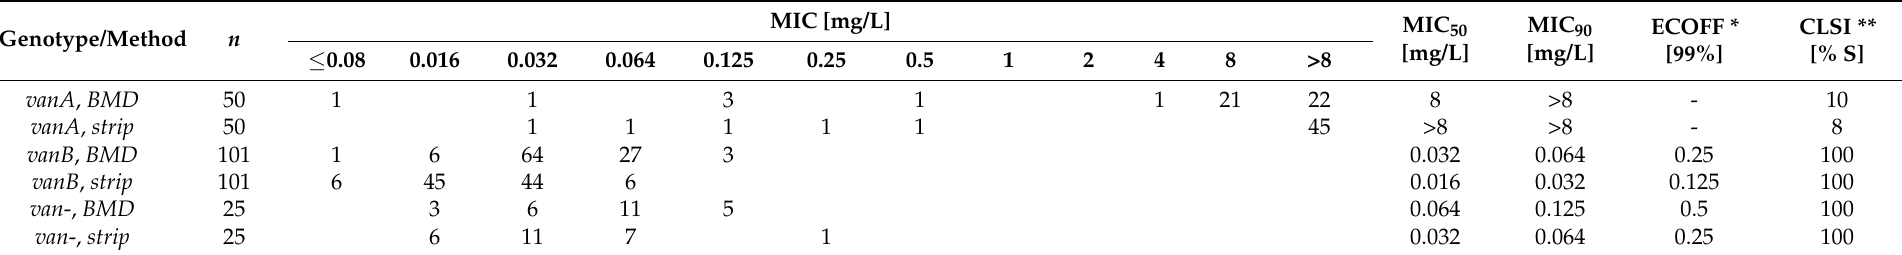
Table 1. Distribution of dalbavancin MICs for E. faecium isolates ( n = 176). MIC gradient strip values were converted into doubling dilution as found in BMD, and values of 16, 32, and >32 mg/L were downsized to >8 mg/L (maximum measurable value by